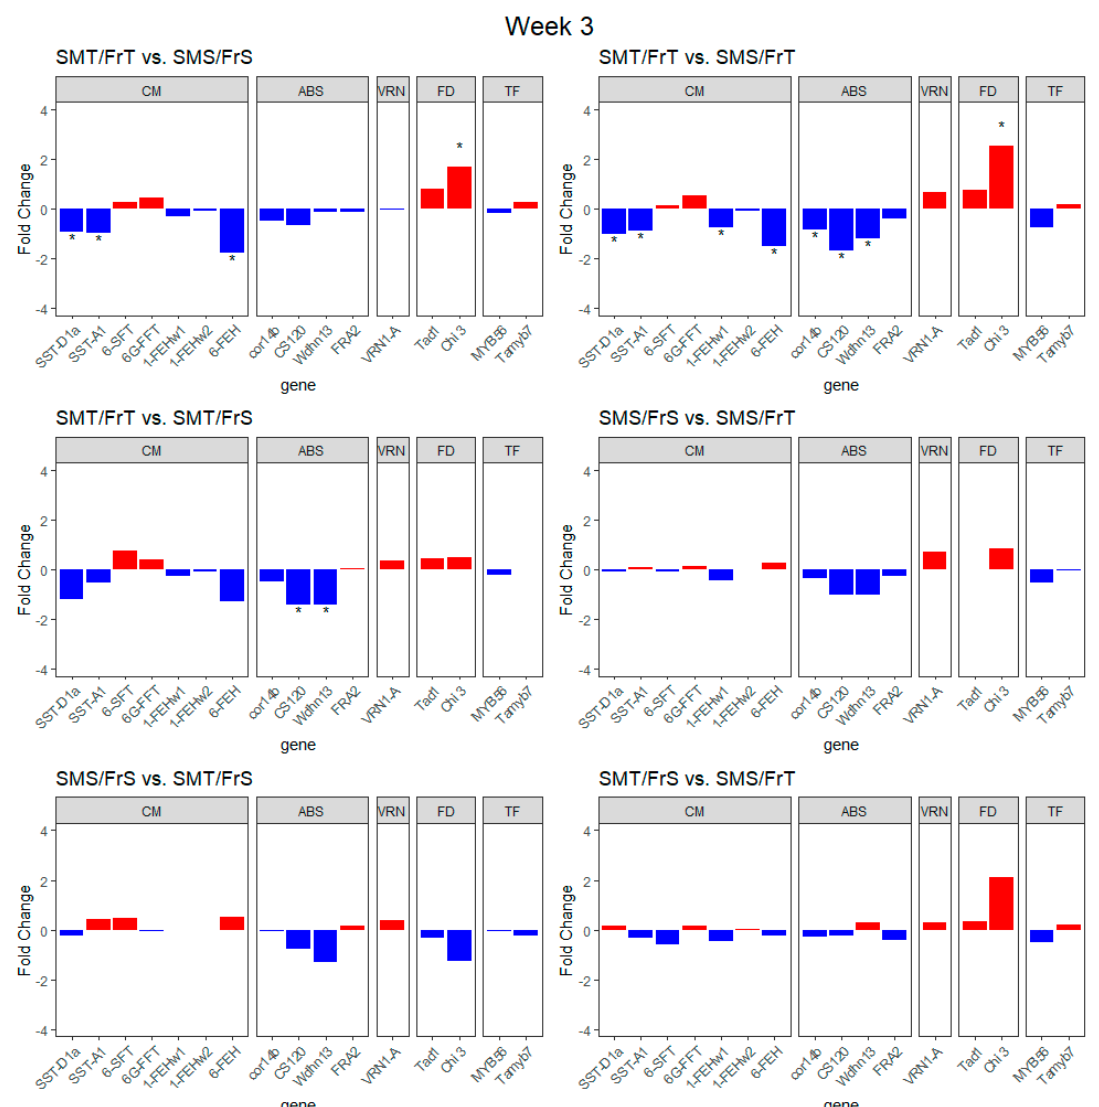
Figure 4. Fold change transcript expression between RILs of different classes of freezing and snow mold tolerance at week 3. Genes were grouped and labeled by the hypothetical function categories; carbohydrate modification, drought/cold stress, vernalization, fungal defense, and transcription factor represented by the abbreviations CM, ABS, VRN, FD, and TF, respectively. “*” denotes genes with significant differences (q < 0.05) in transcript expression between RILs at week 3 of the study. Transcript expression levels of known genes were compared between genotypes after 11 weeks of cold treatment, revealing that the Chi 3 gene, genes related to carbohydrate modification, and genes involved with cold/drought tolerance were significantly differentially regulated between RILs (Figure 5). The SMT/FrT RIL had significantly higher transcript expression of the SST-D1a , SST-A1 , 1-FEHw1 , 6-FEH , CS120 , Wdhn13 , and Chi 3 genes compared to the SMS/FrS RIL. Compared to the SMS/FrT RIL, the SMT/FrT RIL had significantly higher transcript expression of Wdhn13 and Chi 3 genes (Figure 5). The SMT/FrT RIL had significantly higher transcript expression of SST-D1a , 6-FEH , cor14b , CS120 , Wdhn13 , and Chi 3 genes than the SMT/FrS RIL (Figure 5). After 11 weeks of cold